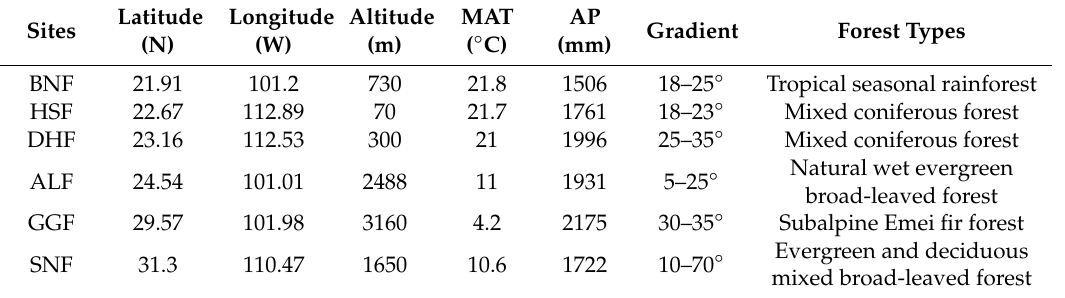
Table 1. Background information for each site. MAT: mean annual temperature; AP: annual